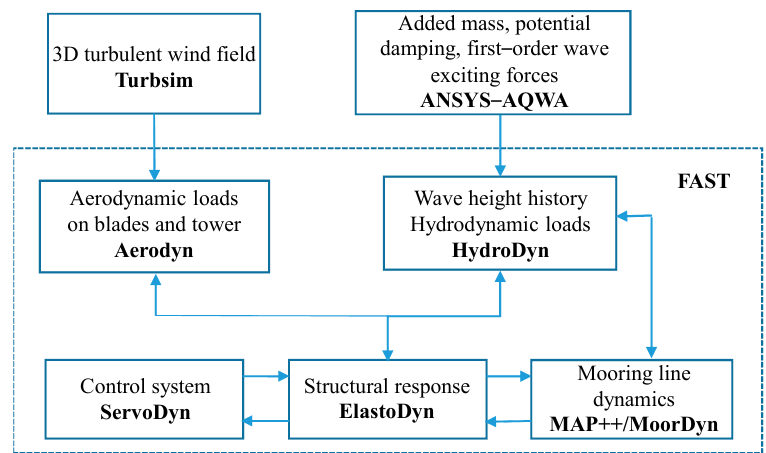
Figure 6. Overview of FAST used in the fully coupled analysis. J. Mar. Sci. Eng. 2019 , 7 , 169